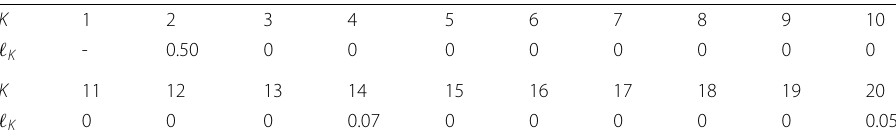
Table 6 Real: evolution of (cid:6) K